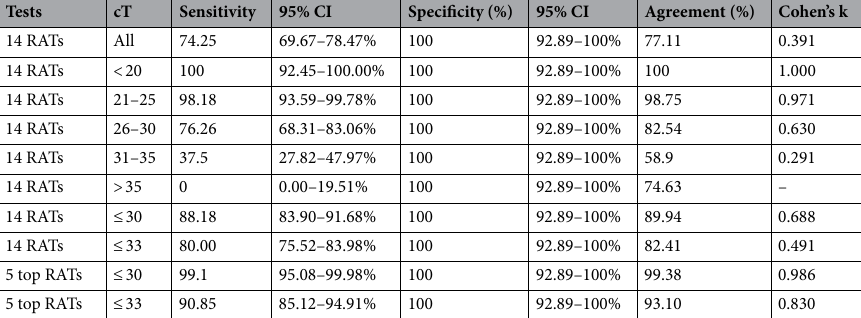
Table 2. Sensitivity, specificity and agreement of RAT combinations at different cTs. Cohen’s k: 0.01–0.20 slight agreement, 0.21–0.40 fair agreement, 0.41–0.60 moderate agreement, 0.61–0.80 substantial